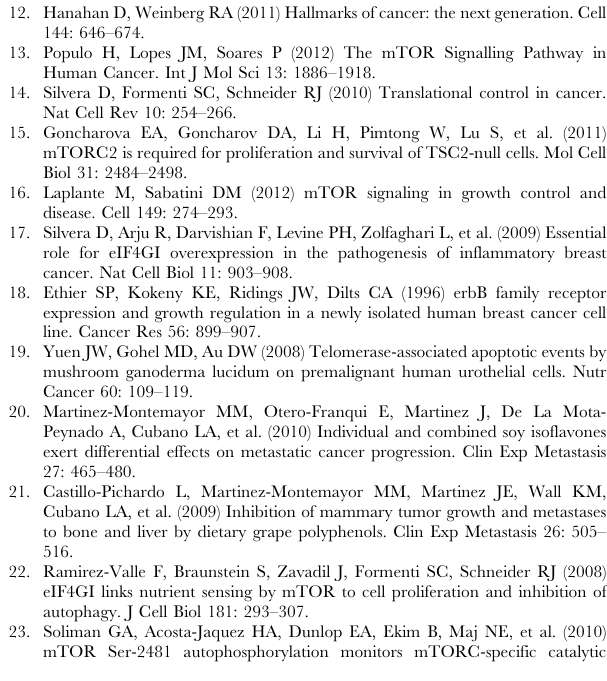
horizontal black line while up-regulated genes are above. Columns Figure S2 Effect of Reishi in the expression of Akt in vitro . A. SUM-149 cells were grown in 5% FBS media for 24 hours prior to treatment with vehicle (0 mg/mL) or Reishi extract (0.5 mg/mL) for 2, 4, and 6 hours before lysis. Equal protein concentration from each sample was used for Western blot analysis with antibodies against total and phosphorylated Akt. B. Columns represent means 6 SEM of integrated density units of protein, normalized to b -actin levels and shown relative to vehicle controls (without Reishi treatment). Figure S3 EIF4F complex levels after 6 h of Reishi treatment in IBC SUM-149 cells. SUM-149 cells were incubated with vehicle (0 mg/mL) or 0.5 mg/mL Reishi for 6 h before lysis. Graph represents eIF4G normalized to eIF4E divided by 4E-BP1 normalized to eIF4E [(eIF4G/eIF4E)/(4E-BP1/ eIF4E)] as in [25]. Columns show means 6 SEM. Reishi does not affect eIF4F complex assembly at 6 h of treatment.